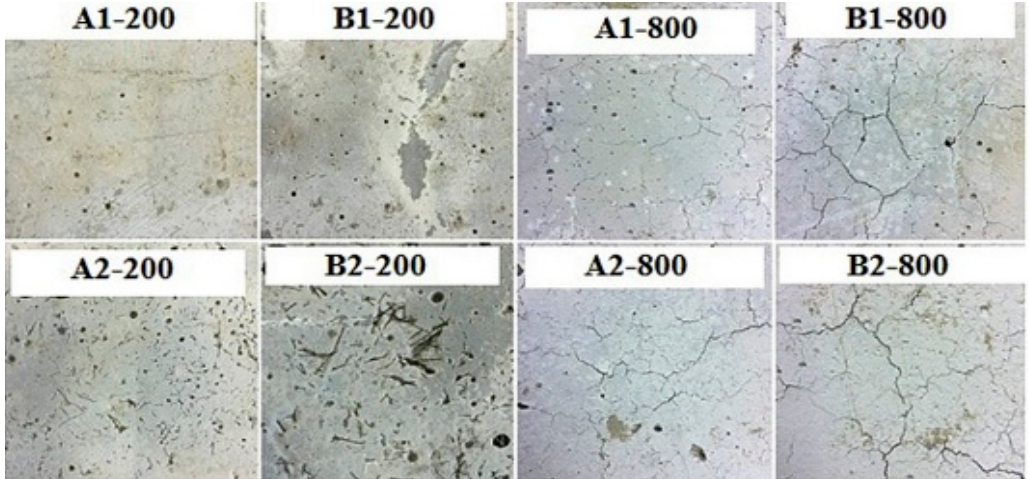
Figure 6. Surface texture of concrete specimens exposed to high temperatures [57]. Reprinted with permission from Elsevier [57].